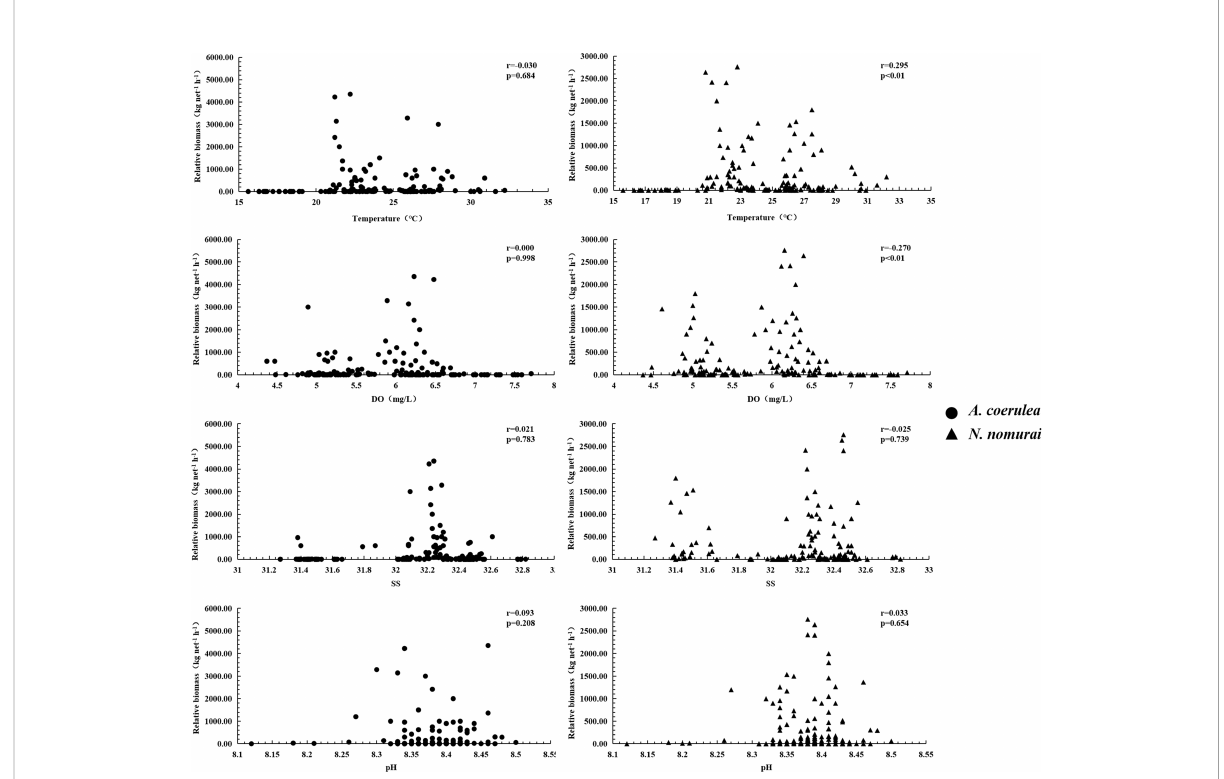
FIGURE 9 Relationship between the RBs of N. nomurai and A. coerulea and the environmental